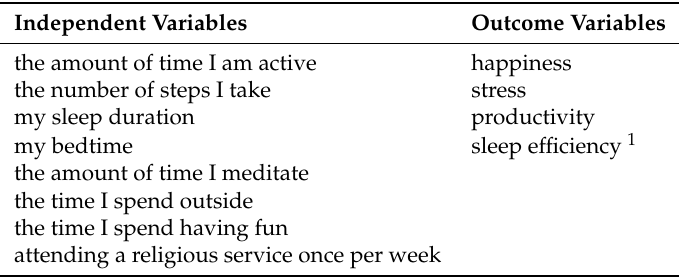
Table 1. Independent and outcome variables used for the interest